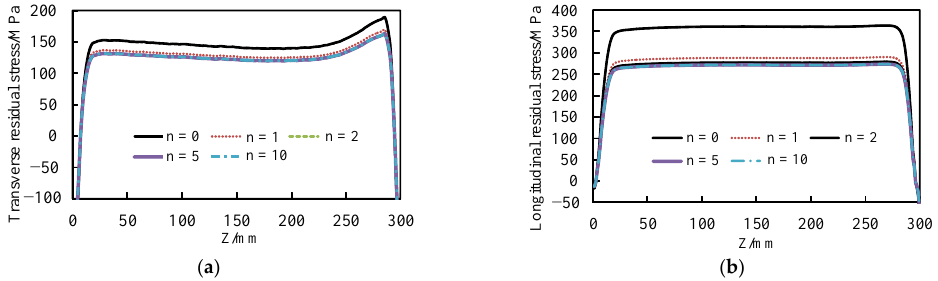
 ; ( b )  . x z  ; ( b )  .  and  gradually decrease, the magni- x z x z